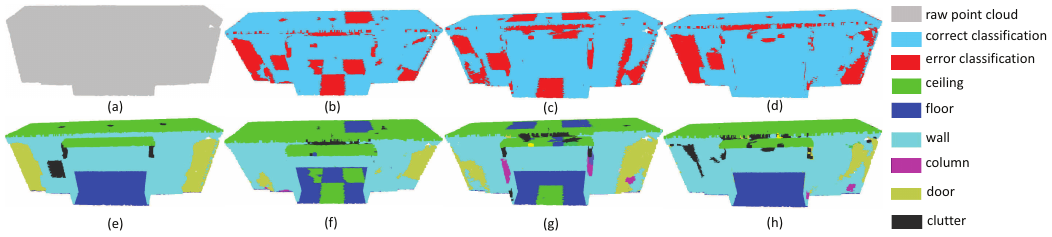
Figure 16. The segmentation results on HallWayS 3 D . ( a ) input, ( e ) ground truth, ( b , f ) the classification result by PointNet++, ( c , g ) the classification result by PointSIFT, and ( d , h ) the classification result by